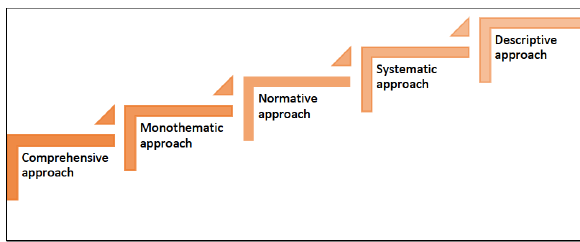
Figure 7: Approaches to economic analysis of AGV